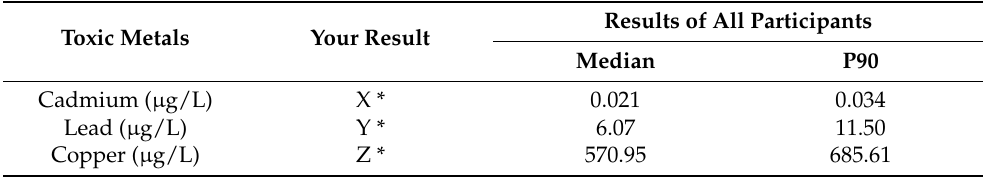
Table 1. Illustration of the data format used for individual report-back of HBM results for three out of seventeen biomarkers (translated from Dutch) (2013–2015).